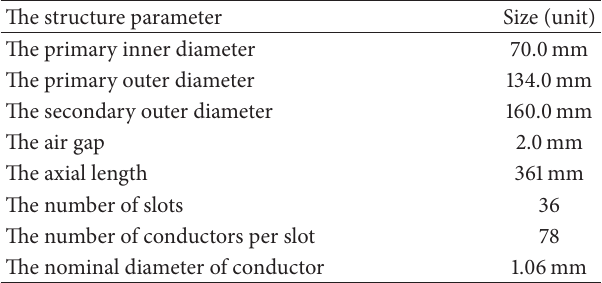
Table 1: TPMLWG structure